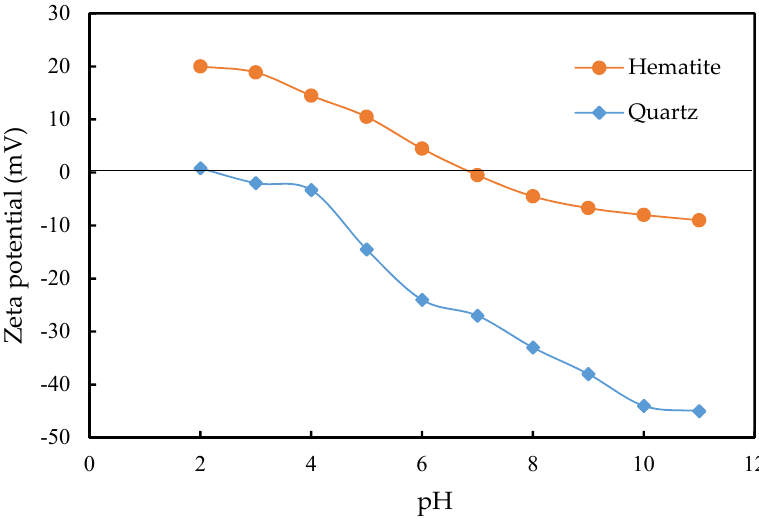
Figure 3. Zeta potential of quartz and hematite as a function of pH (after [49]).